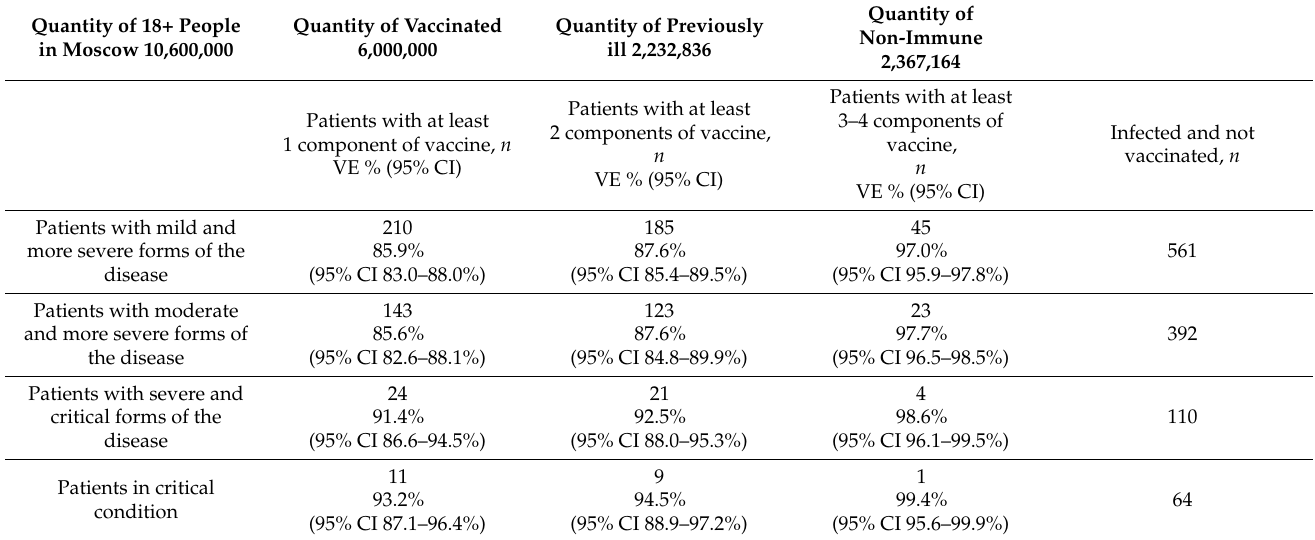
Figure 3. Effectiveness of vaccination in relation to the varying severity of the disease among hospitalized patients, considering the number of vaccine doses received. ( A ) Protection from any cases of hospitalization, ( B ) protection from moderate-severe and more severe cases, ( C ) protection from severe and critical cases, and ( D ) protection from critical cases (VE 95% CI). Table 5. Analysis of the epidemiological efficacy of vaccination in protection against the severe course of COVID-19 in hospitalized